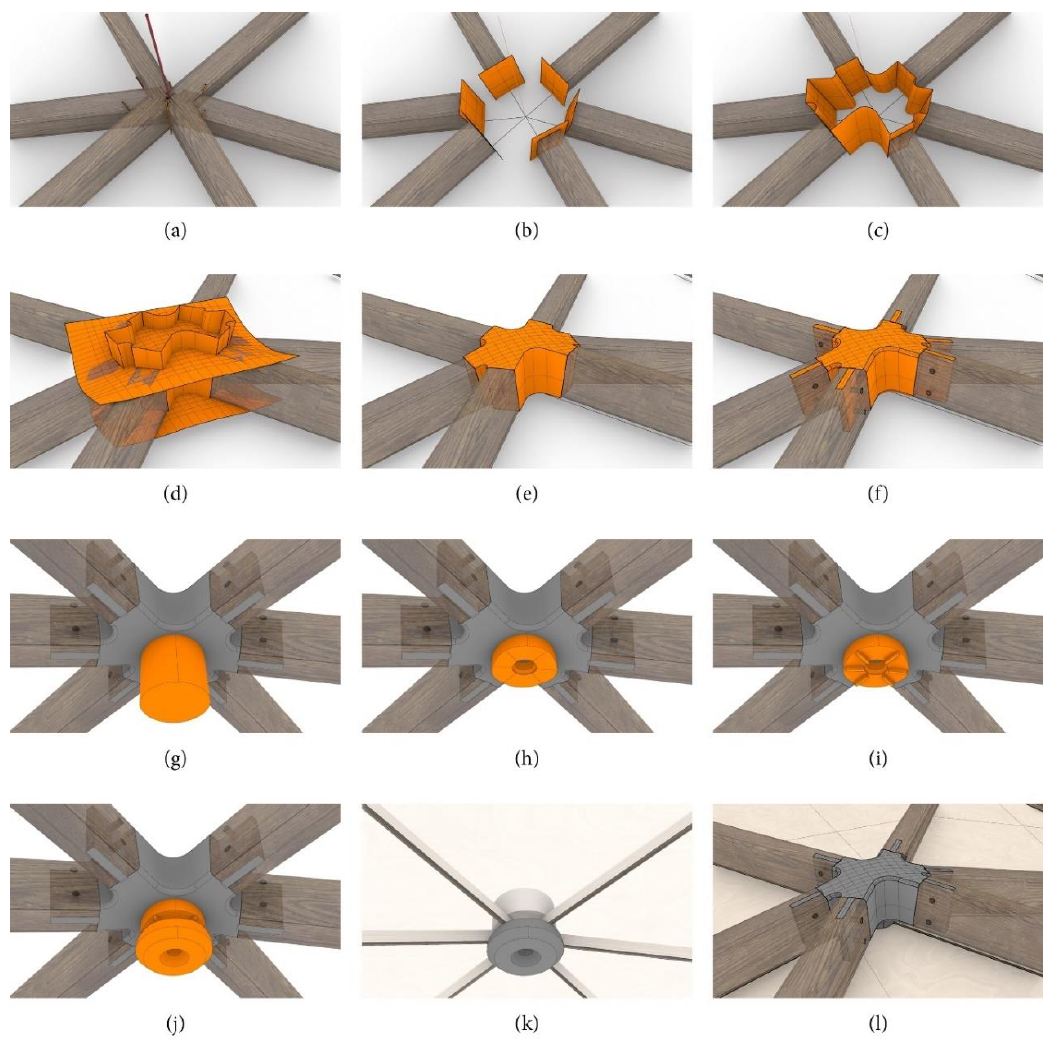
Figure 11. ( a ) Frame member intersection; ( b ) cutting planes; ( c ) lateral area of the knot; ( d ) patched surfaces; ( e ) basic knot geometry; ( f ) knot with connecting tongues (mortise joints) joining the frame members; ( g ) cylinder parallel to knot axis; ( h ) adapter on the inside of the knot 1st step; ( i ) finished adapter on the inside of the knot; ( j ) bracket for the fixation of the panels; ( k ) panel fixation detail; ( l ) final appearance from outside.